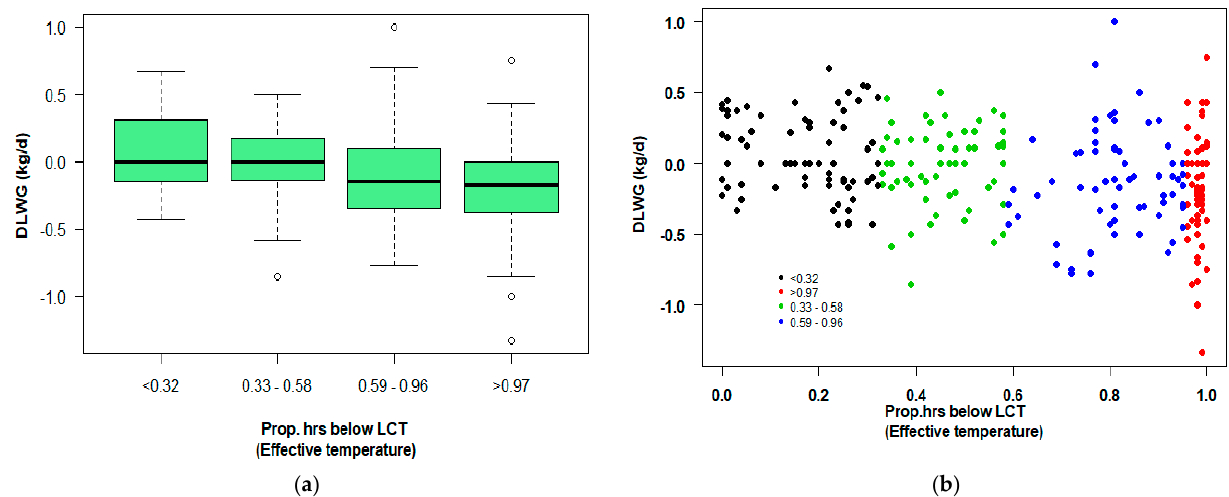
Figure 3. ( a ) Effect of proportion of hours for which effective temperature was below LCT on daily liveweight gain (DLWG, kg/d) for the period between birth and entering the group housing igloo (B2G); ( b ) scatterplot of daily liveweight gain (DLWG, kg/d) and the proportion of hours for which effective temperature was below LCT.